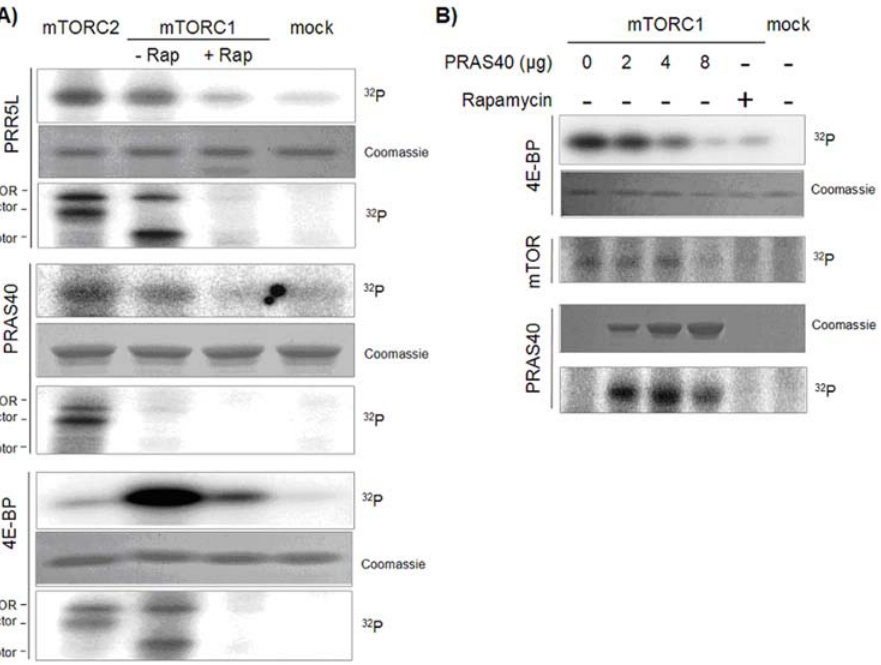
Figure 3. mTOR phosphorylates PRAS40 and PRR5L, and PRAS40 inhibits mTOR kinase activity. A. mTOR phosphorylates PRAS40 and PRR5L. Kinase assays were performed using mTORC1 or mTORC2 immunopurified from HEK293 cells, and purified PRAS40, GST-PRR5L (PRR5L) or 4E-BP as substrates. Rapamycin (100 nM) and purified FKBP12 were added directly to the reaction. Both PRR5L and PRAS40 are phosphorylated in vitro by both mTORCs. Phosphorylation by mTORC1 was rapamycin-sensitive. B. PRAS40 inhibits mTORC1 kinase activity toward 4E-BP and PRAS40 itself. Kinase assays were performed using mTORC1 immunopurified from HEK293 cells, purified 4E-BP as a substrate, and increasing concentrations of PRAS40. PRAS40 inhibits mTORC1 autophosphorylation and mTORC1 phosphorylation of 4E-BP and PRAS40, in a concentration-dependent